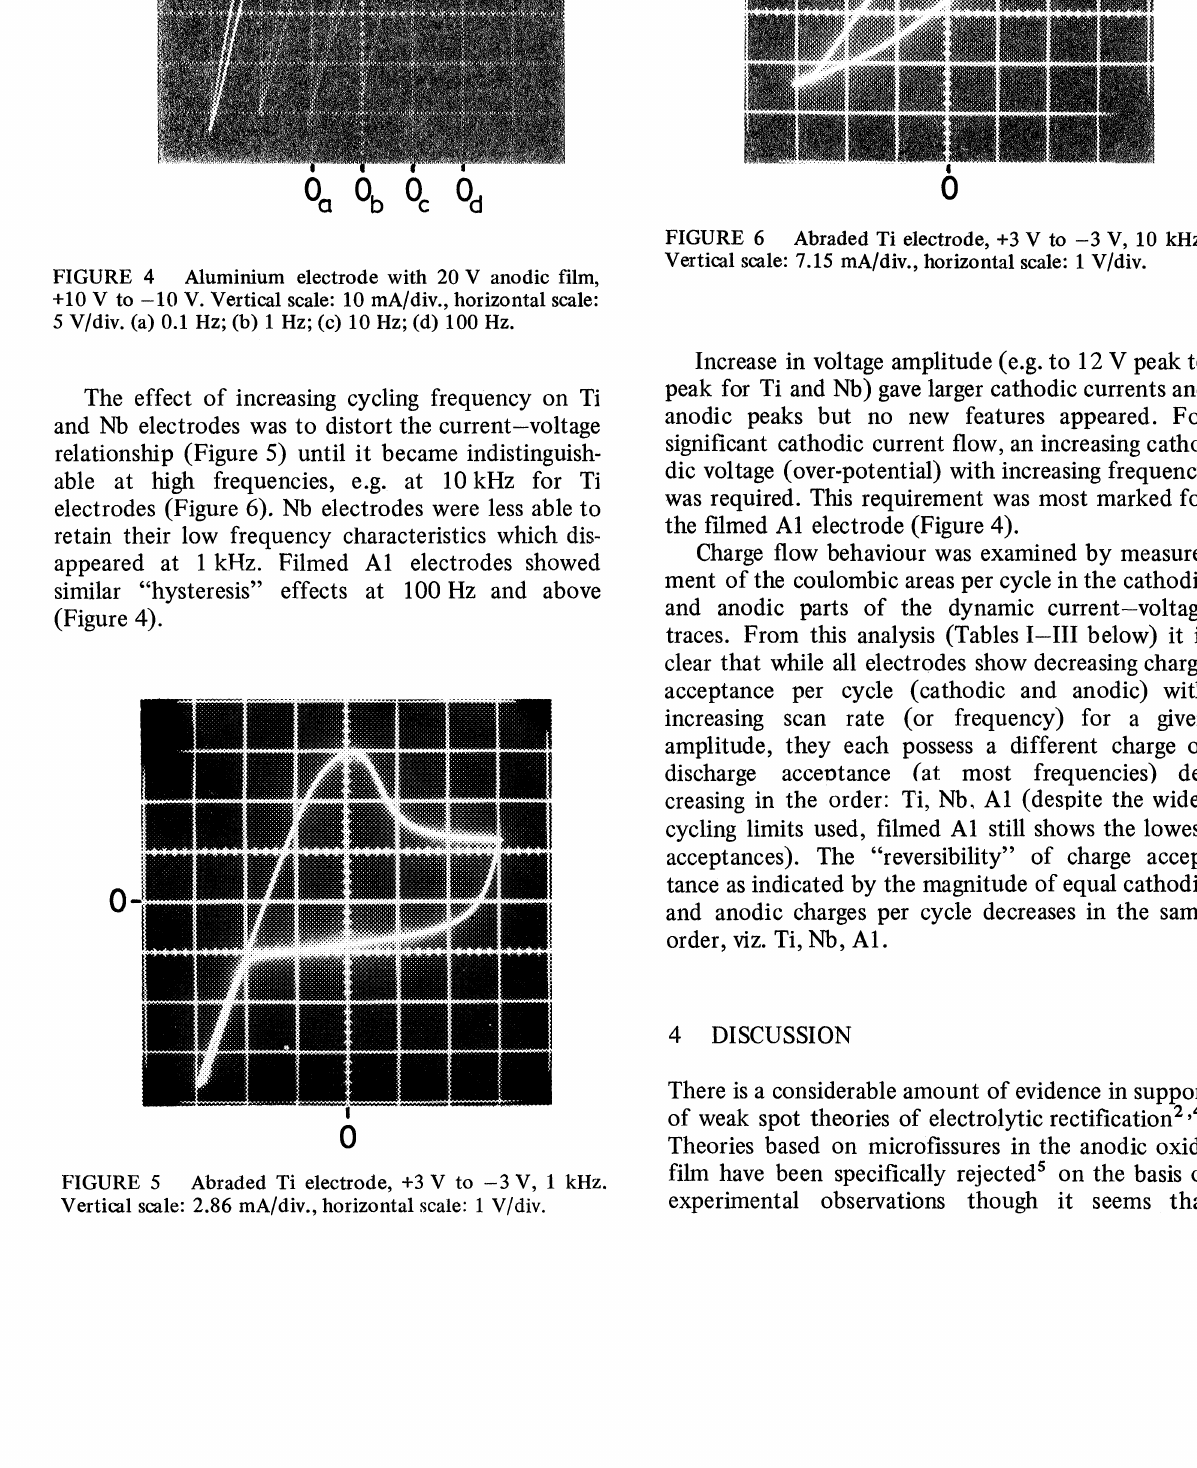
FIGURE 6 Abraded Ti electrode, +3 V to -3 V, 10 kHz. Vertical scale: 7.15 mA/div., horizontal scale: V]div.